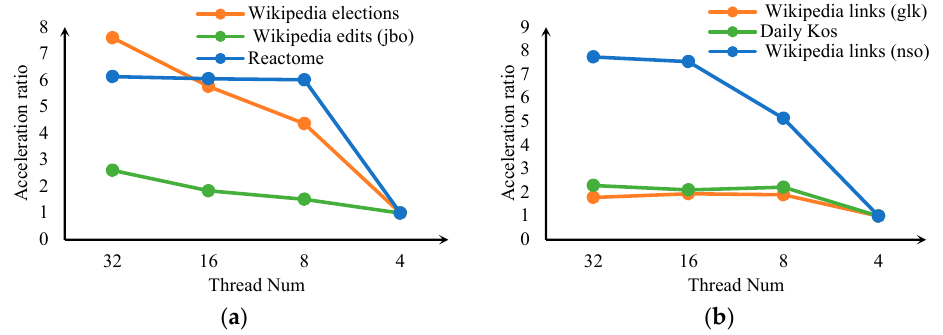
Figure 7. HRNS speedup in different datasets. ( a ) Parallel acceleration ratio (Wikipedia and Reactome). ( b ) Parallel acceleration ratio (Wikipedia and Daily Kos).